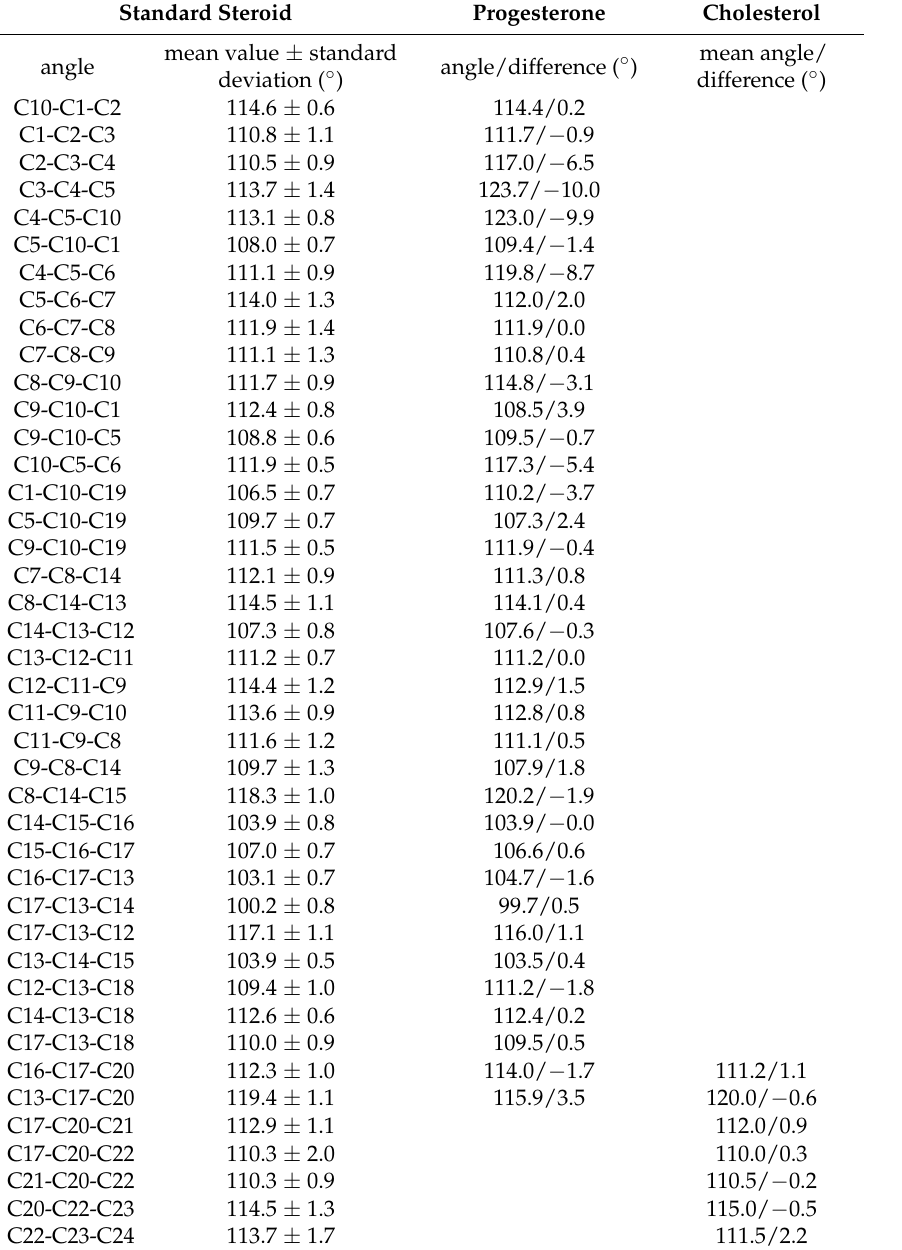
Table 6. Mean values and standard deviations for the bond angles of the steroids analyzed in this paper, and comparison with progesterone and the lateral chain of